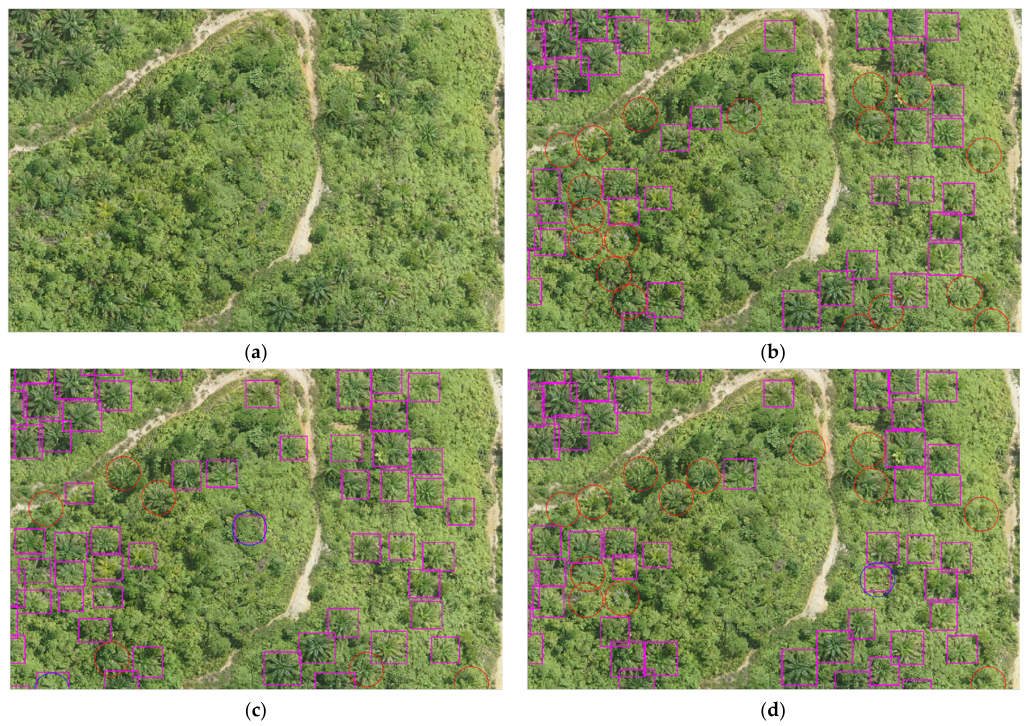
Figure 18. Oil palm trees with nutrient deficiency; ( a ) Original image; ( b ) YOLOv3 detection; ( c ) YOLOv4 detection; ( d ) YOLOv5m detection.